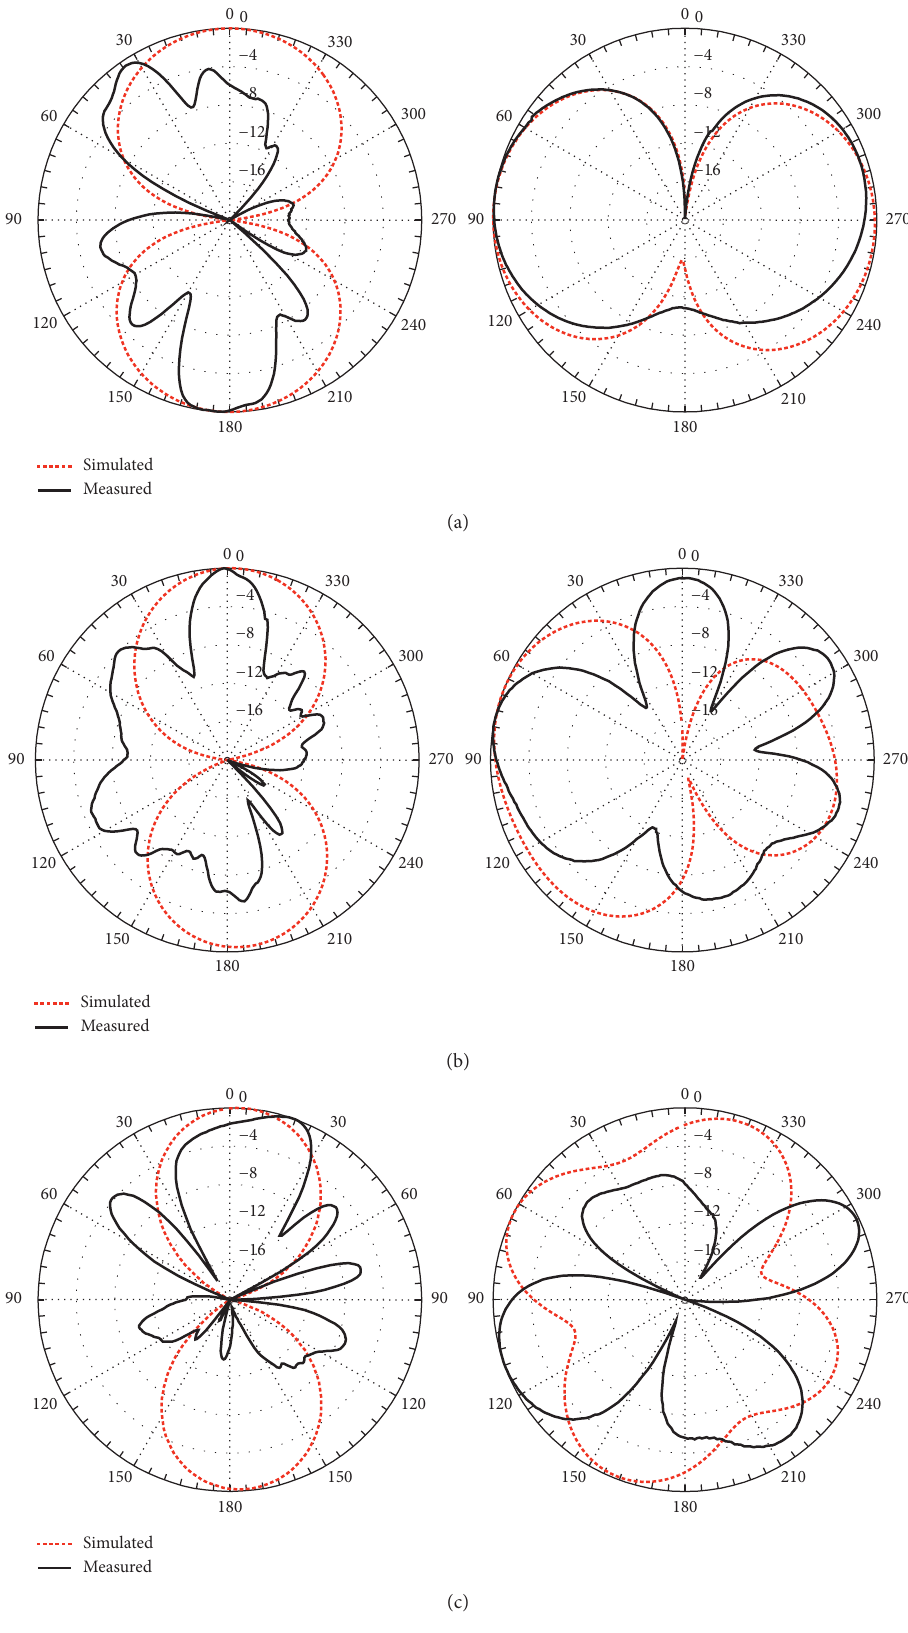
Figure 13: Comparison between the simulated and measured 2D radiation patterns for XZ plane (left) and XY plane (right) at (a) 900, (b) 1730, and (c) 2400